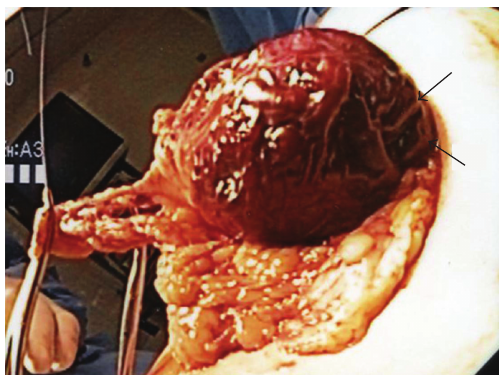
Figure 1: Intraoperative specimen of stomach at partial gastrec- tomy showing the rich vascular abnormality seen within the pos- terior gastric wall